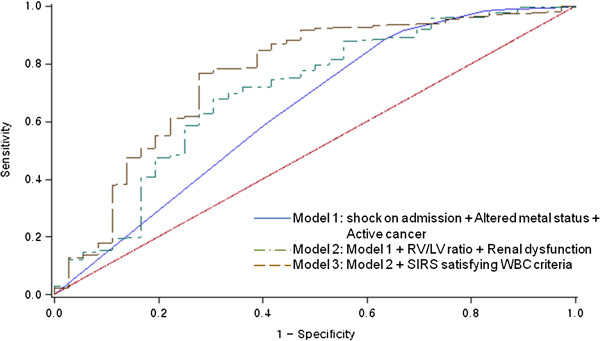
Receiver operating characteristic curves for the 30-day mortality. The curves are based on logistic regression models for risk prediction, incorporating the following: Model 1, shock on admission + altered mental state + active cancer (AUC = 0.64; 95% CI, 0.53–0.74); Model 1 + RV/LV ratio + renal dysfunction (AUC = 0.70; 95% CI, 0.59–0.76); Model 1 + RV/LV ratio + renal dysfunction + SIRS satisfying the WBC criterion (AUC = 0.76; 95% CI, 0.66–0.85), P = 0.05 versus Model 1. AUC: area under the receiver operating characteristic curve; CI: confidence interval; RV: right ventricle; LV: left ventricle; SIRS: systemic inflammatory response syndrome; WBC: white blood cell.